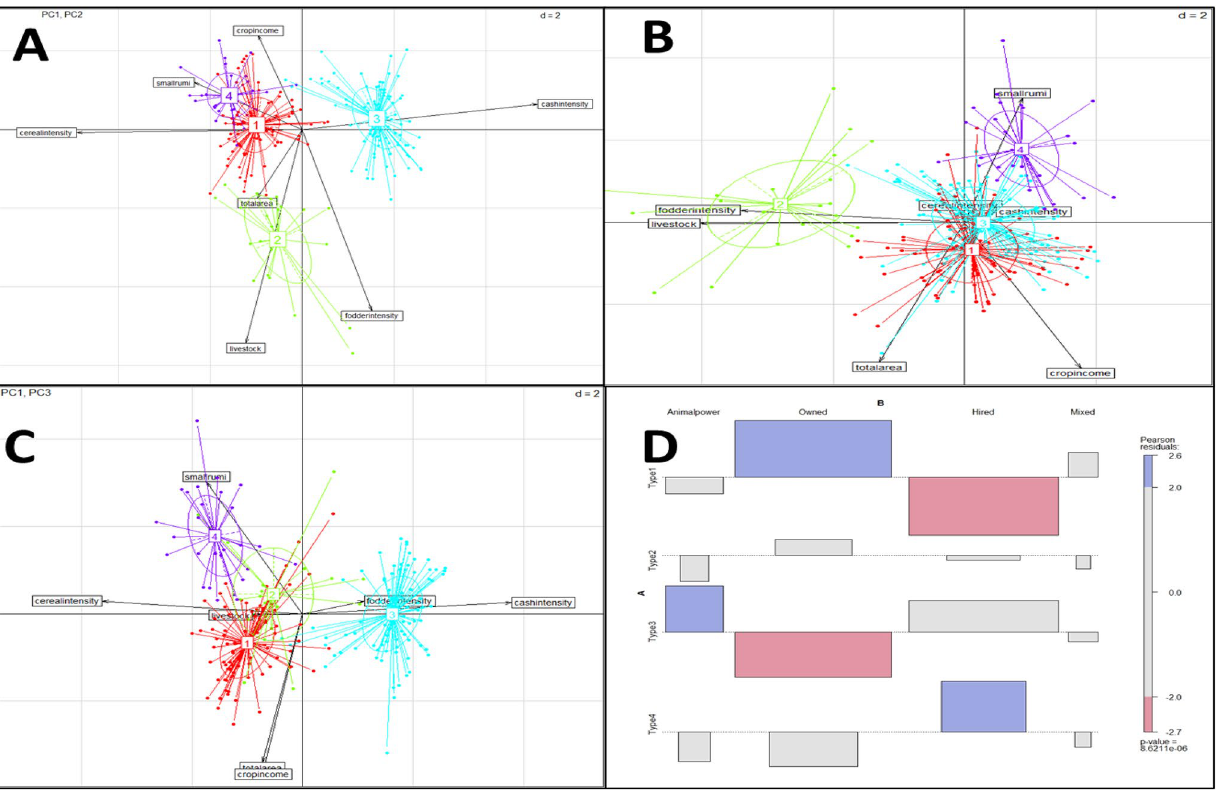
Figure 5. ( A – C ) Spatial distribution of different farm types. ( D ) Pearson residuals visualization after chi- squared test of mechanization status vs different farm types (Blue rectangles show significantly positive associations, and pink rectangles depict significantly negative associations, gray rectangles show non-significant